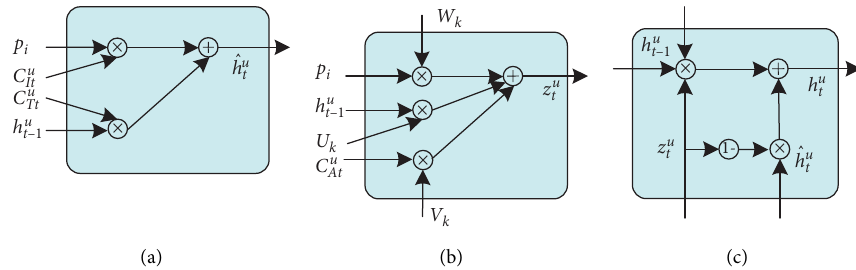
Figure 1: Defnition of candidate knowledge, update gate, and hidden state of at the moment t : (a) candidate knowledge, (b) update gate, and (c) the hidden state of at the moment t